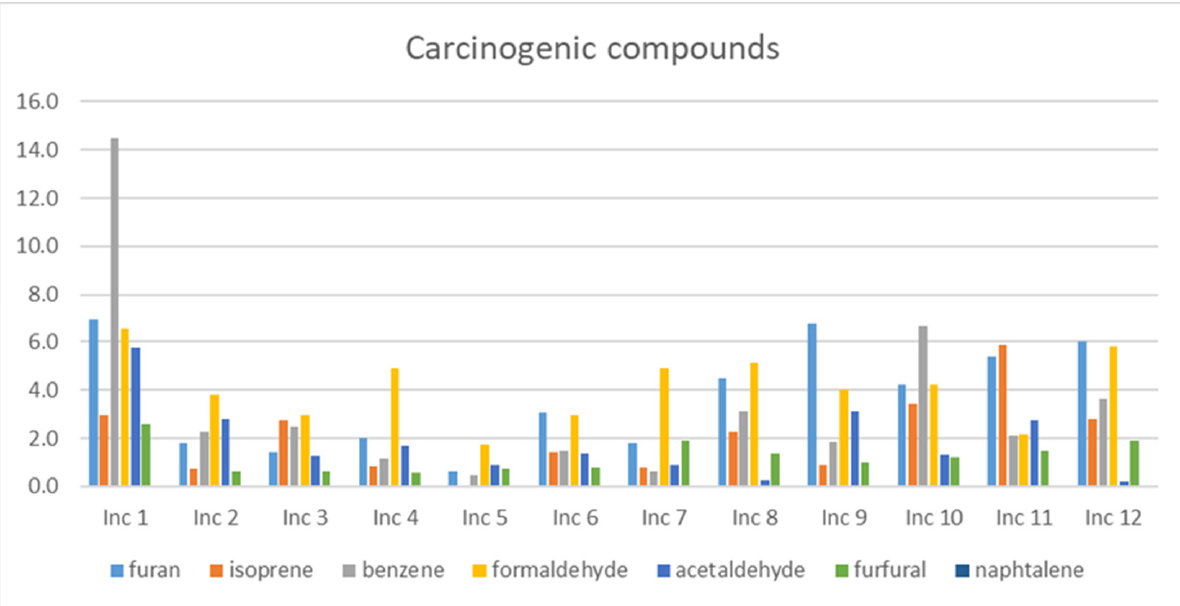
Figure 1. TWA levels ( μ g/m 3 ) of the carcinogenic and suspected to be carcinogenic compounds in the twelve products studied.